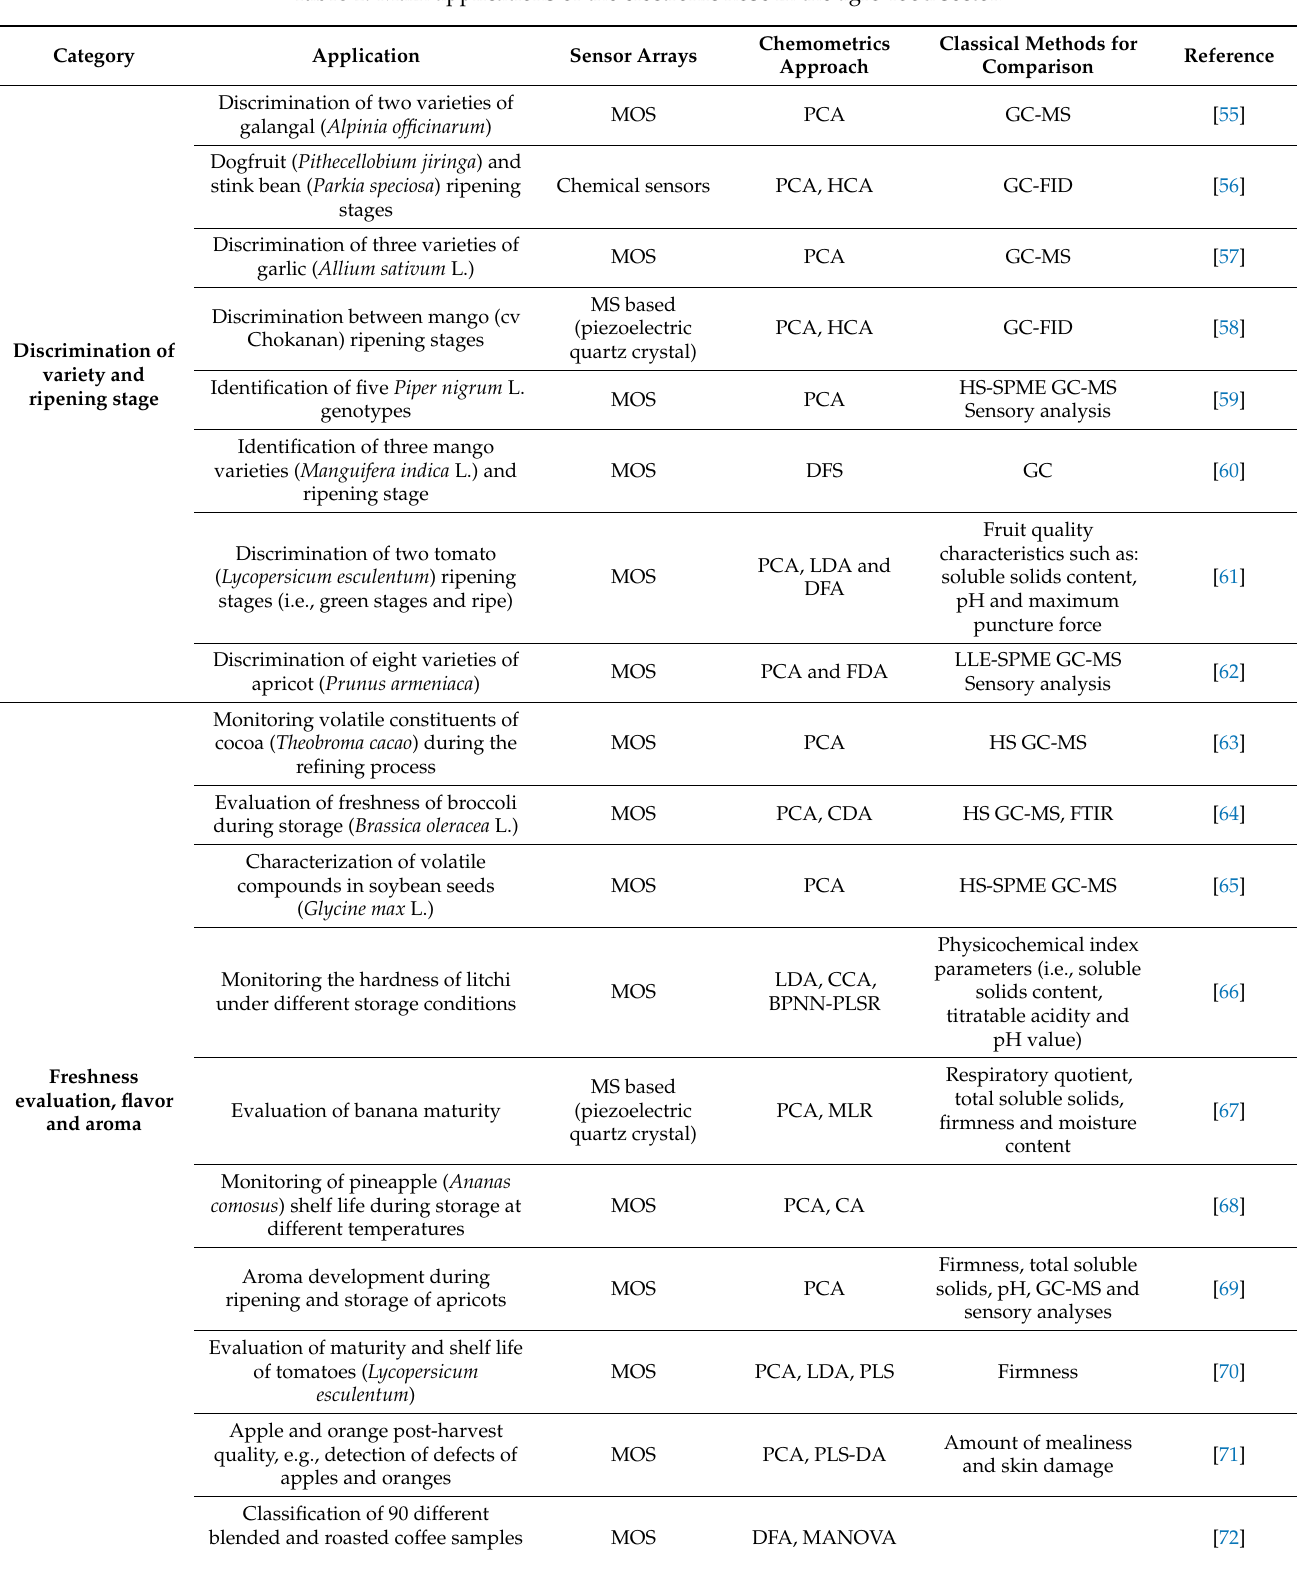
Table 1. Main applications of the electronic nose in the agro-food